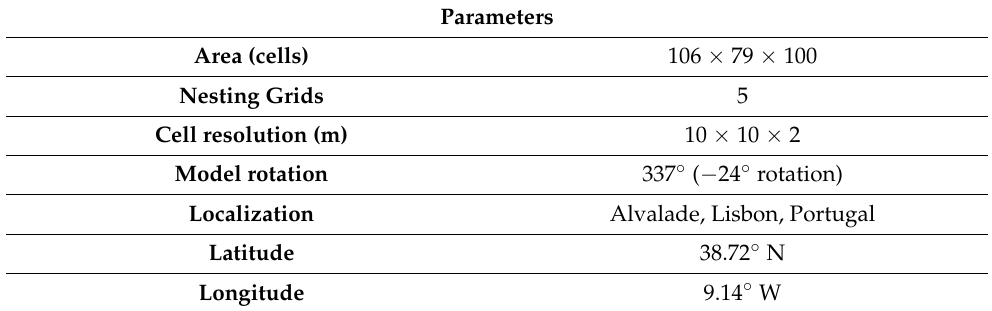
Table 2. Input parameters to build the 3D model of the Alvalade in ENVI-MET neighborhood.